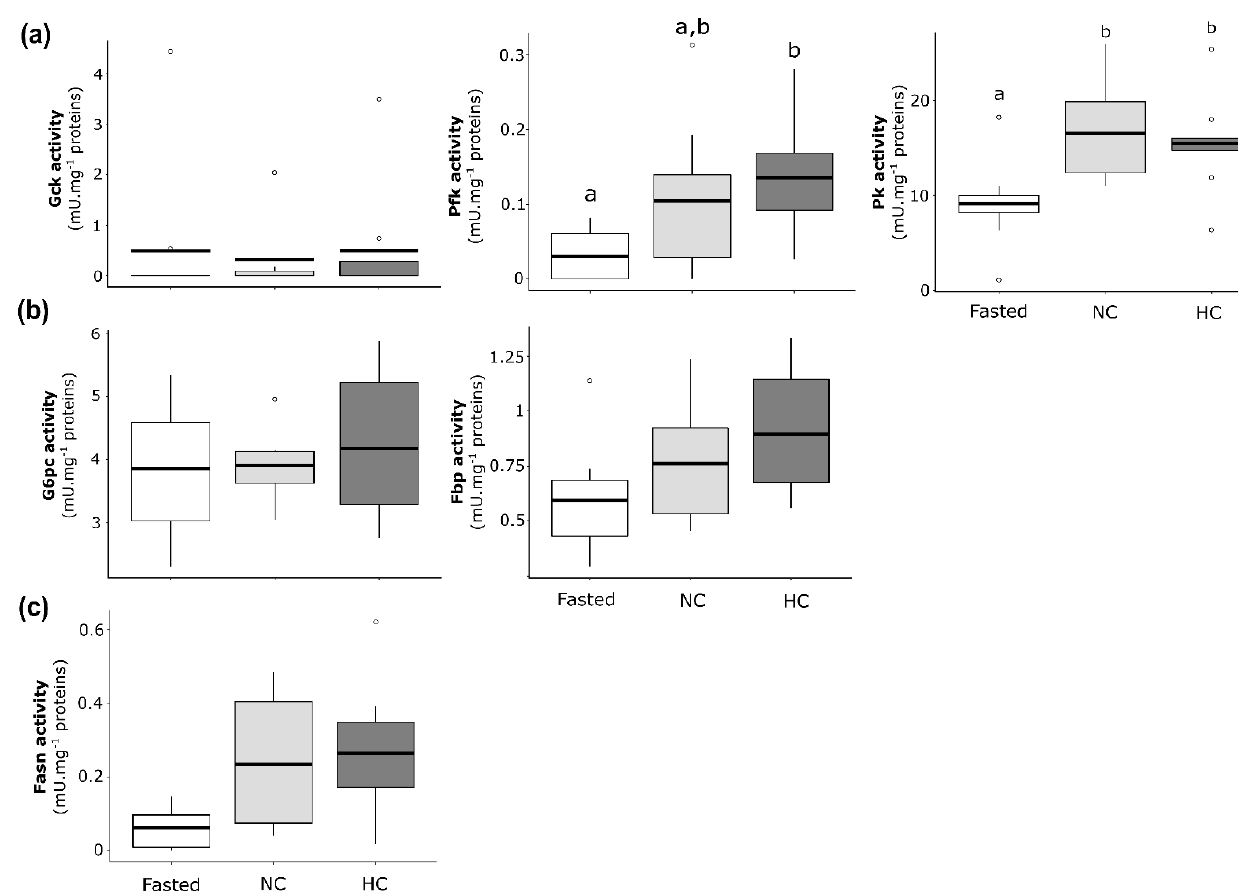
Figure 3. Enzymatic activities of glucose and lipid metabolism actors in the liver of mature female rainbow trout fasted (Fasted, white), fed with a non-carbohydrate diet (NC, grey) or fed with a high-carbohydrate diet (HC, dark grey). Enzymatic activities are expressed as mU · mg − 1 of proteins for ( a ) glycolysis with the glucokinase (Gck), the phosphofructokinase (Pfk) and the pyruvate kinase (Pk), ( b ) gluconeogenesis with the glucose-6-phosphatase (G6pc) and the fructose-1,6- bisphosphatase (Fbp) and ( c ) de novo lipogenesis with the fatty acid synthase (Fasn).